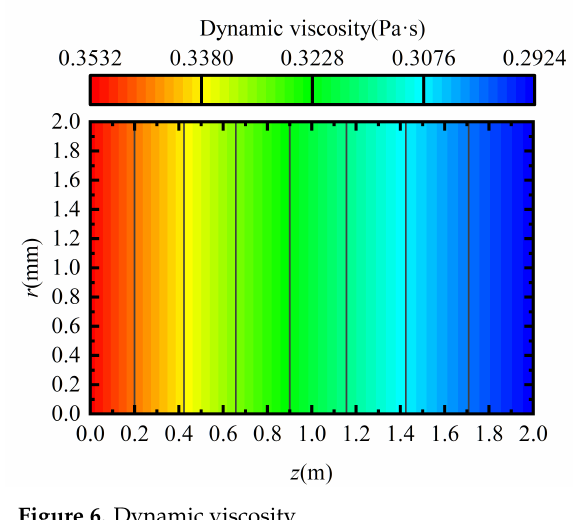
Figure 6. Dynamic viscosity.